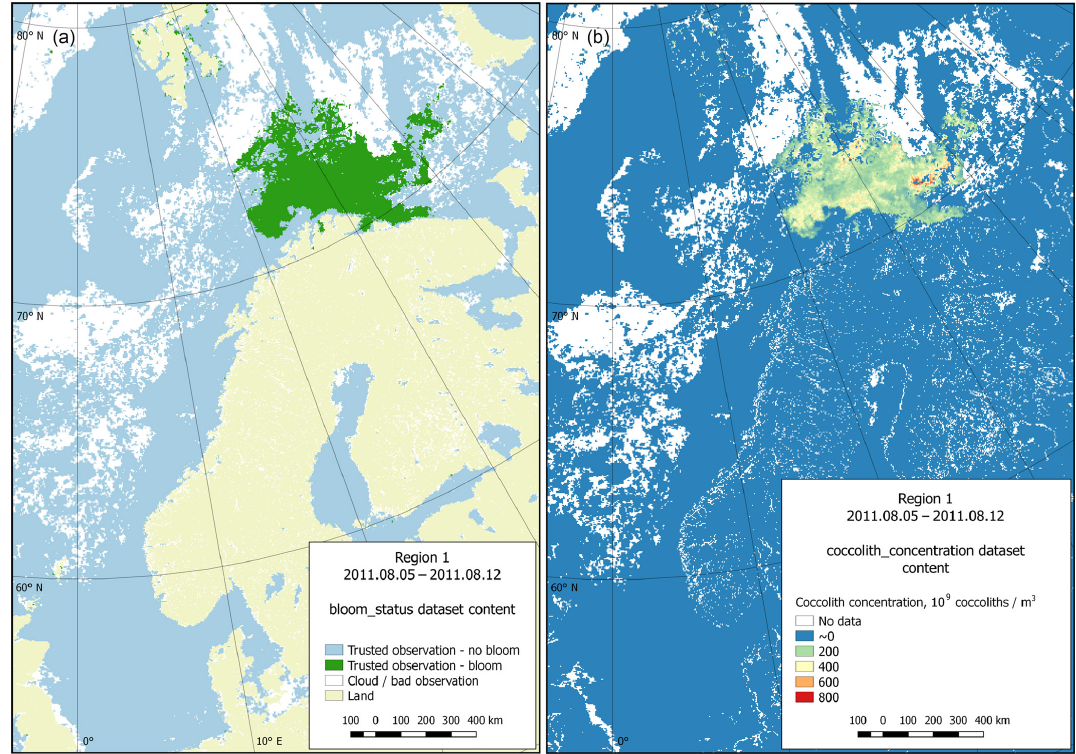
Figure 7. Dataset content example (region 1, 5 August 2011). (a) Bloom status sub-dataset visualisation; (b) coccolith concentration sub- dataset